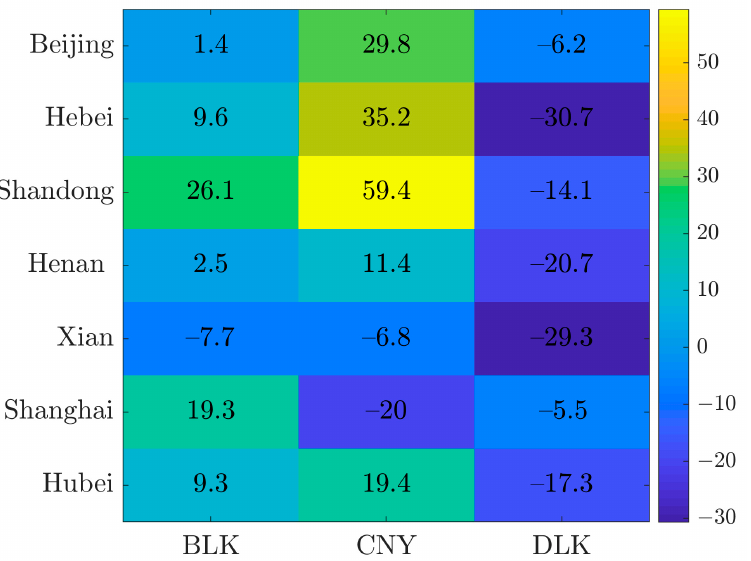
Figure 9. Percentage change (%) in satellite-derived PM 2.5 concentrations for three consecutive timeframes in early 2020 (BLK, CNY and DLK) for seven regions across China, compared with equivalent periods for the reference year 2019.